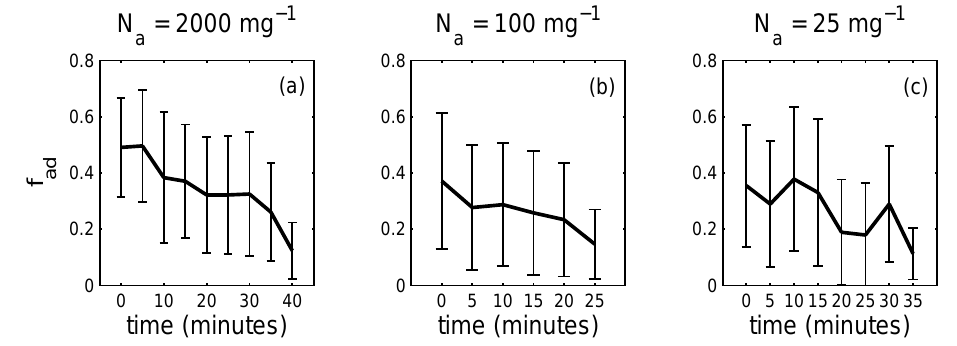
Fig. 6. Evolution of f ad for the individual clouds shown in Fig.